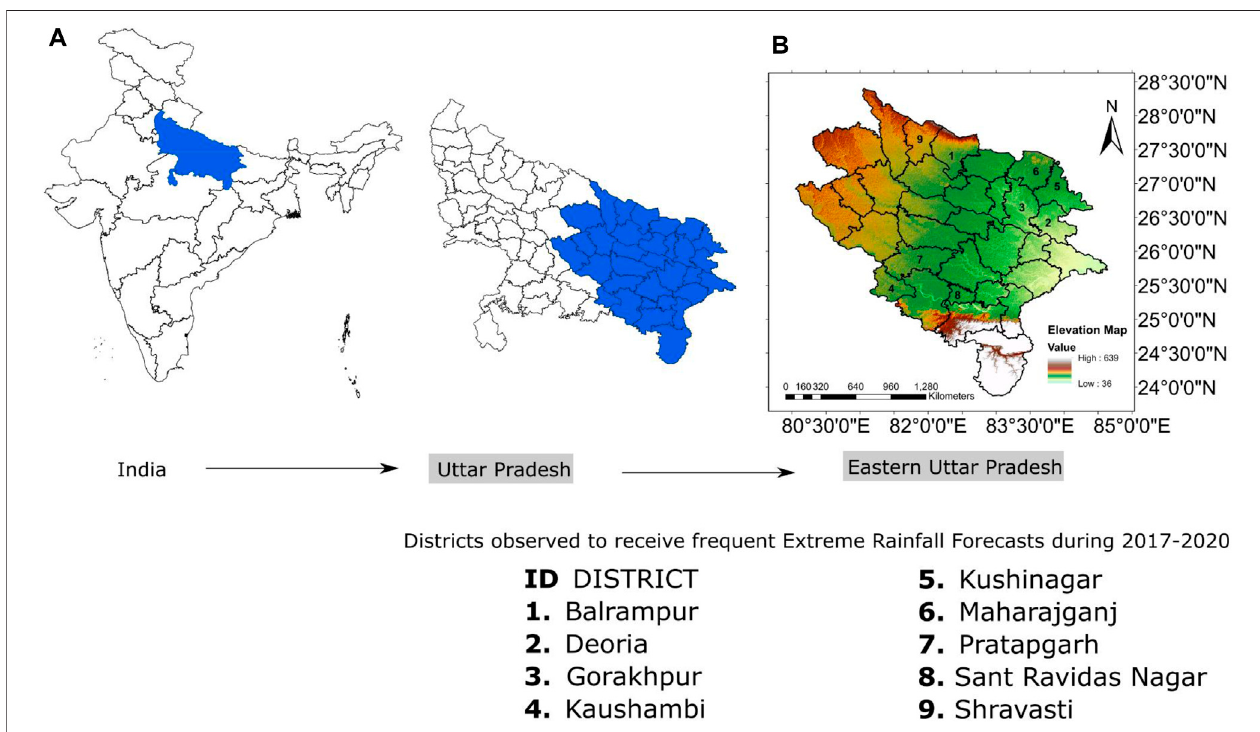
FIGURE1 | The study areamap showing (A) the state of Uttar Pradesh in India; (B) the expanded view ofthe districtsin Uttar Pradesh (East) selected as the study area along with the names of key districts for this study which are prone to frequent extreme rainfall forecasts.